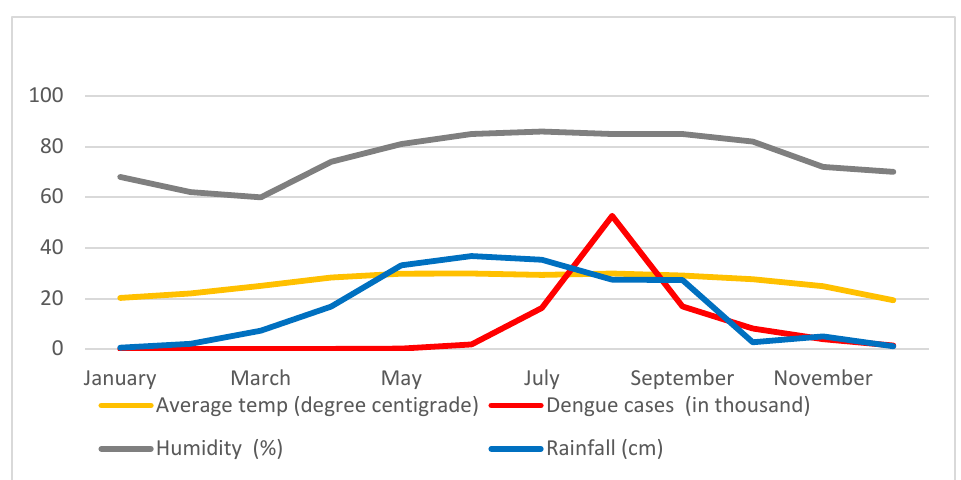
Figure 9. Correlation between dengue cases (1000 × ), rainfall (cm), average temperature (centigrade), and relative humidity (%).